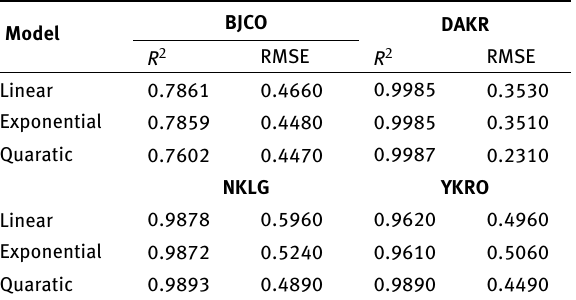
Table4: R 2 and RMSE betweencomputedPWandpredictedPWusing regression models